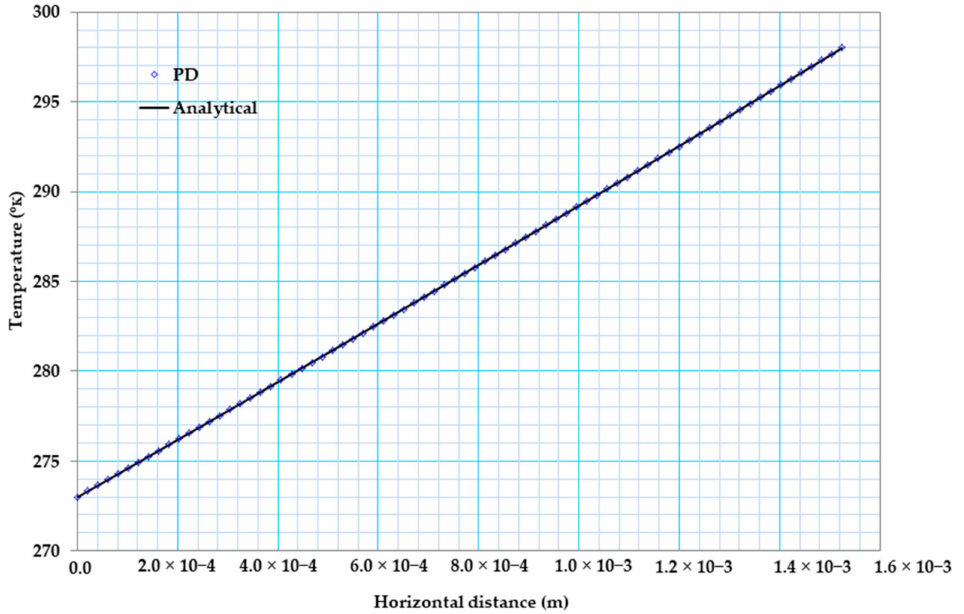
Figure 9. 2D temperature variations from PD and analytical solutions for temperature-dependent material